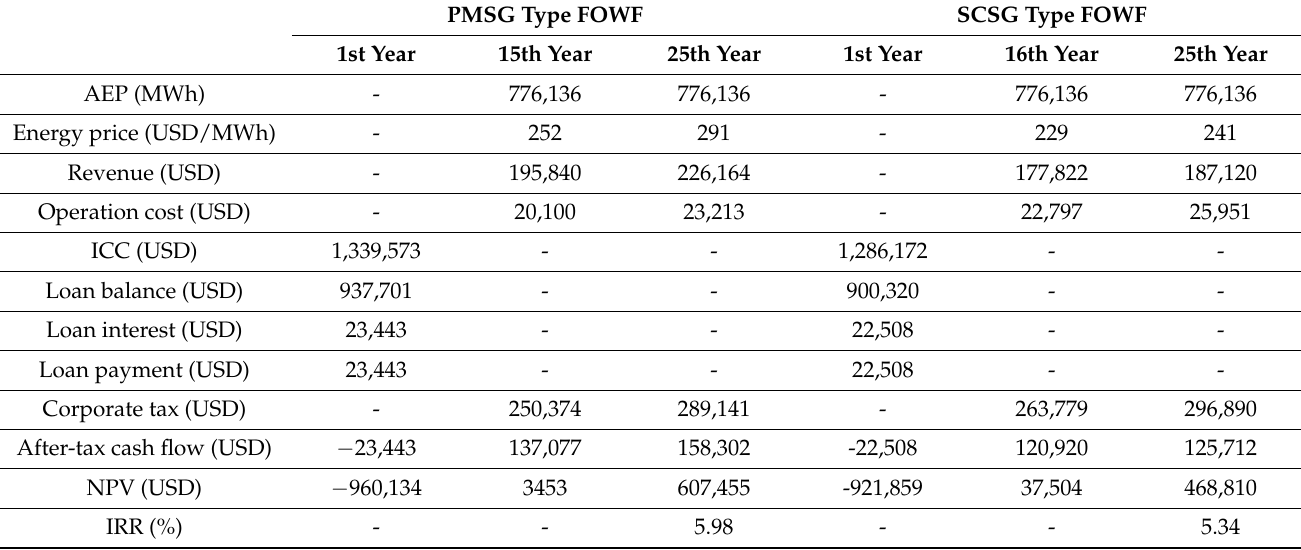
Table 18. Evaluation results of economic feasibility of the 200 MW class PMSG and SCSG type